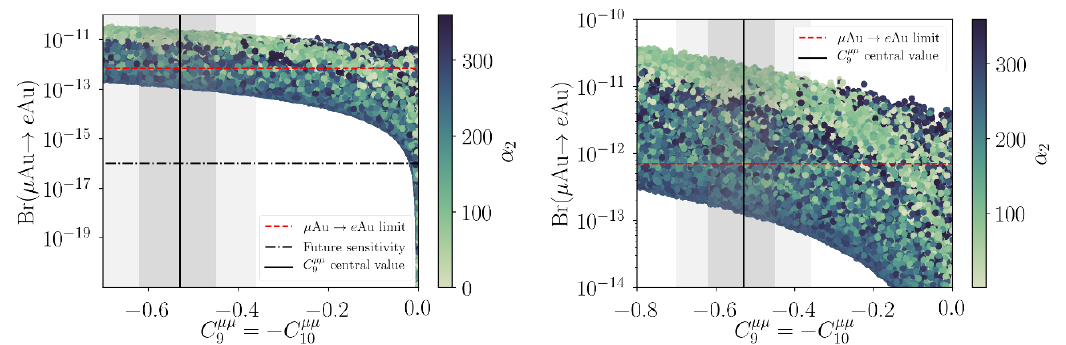
Figure 17. The results of the random scan projected onto Br( (cid:22) Au ! e Au) and C (cid:22)(cid:22) straints except muon-electron conversion in Gold have been applied. The solid black line represents the central value of the (cid:12)t of ref. [30] to the anomalous b ! s data, and the heavier and lighter shaded regions are the 1 and 2 (cid:27) regions. The dashed red line corresponds to the current most stringent limit on Br( (cid:22) Au ! e Au) from SINDRUM II [131] and the black dot-dashed line is a representation of the projected sensitivity of future experimental reach [132{138]. The plot on the right is an enlarged look at the interesting region of the plot on the left. The colour axis represents the value of the Majorana phase (cid:11) 2 .